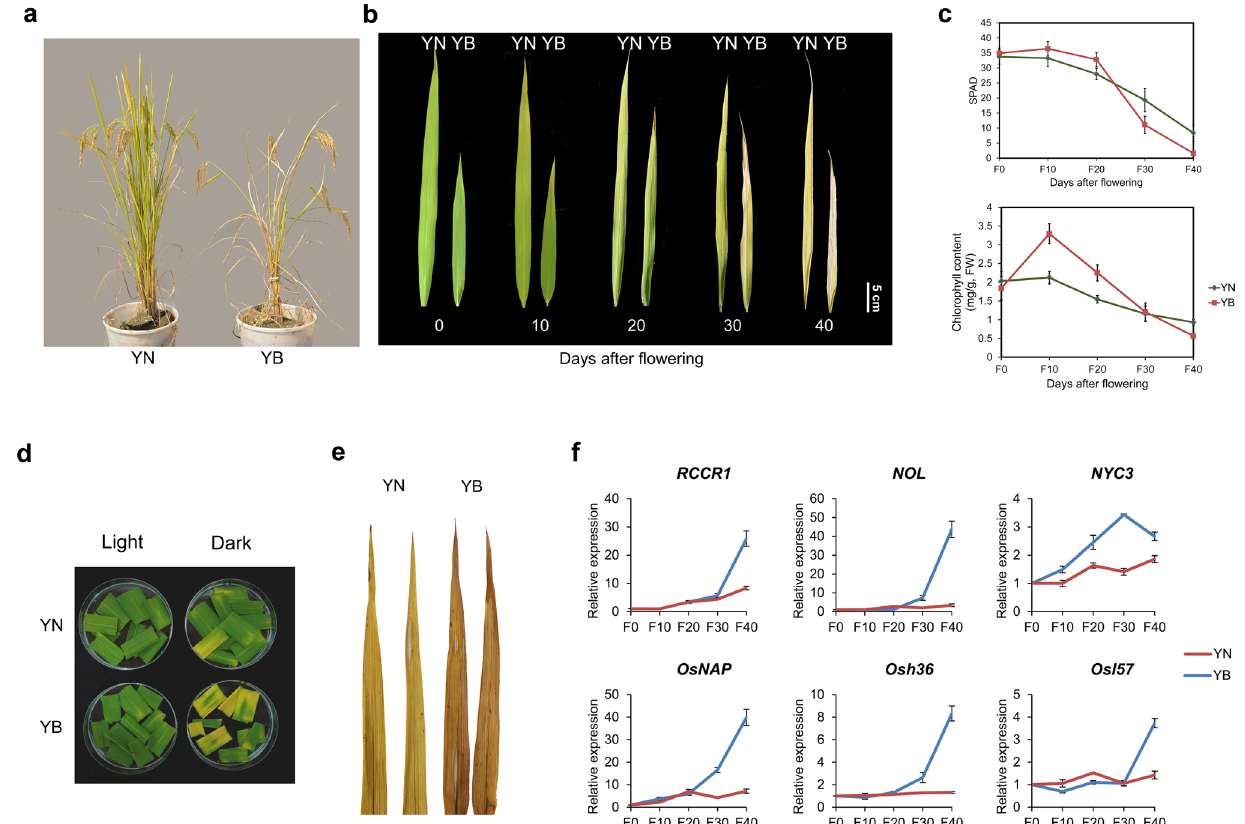
Figure 1. Phenotypes of two rice cultivars. ( a ) Phenotypes of YN and YB at 30 DAF. YN is shown on the left, and YB in shown on the right. ( b ) Phenotypes of flag leaves of YN and YB plants at different stages after flowering. Bars = 5 cm. ( c ) SPAD values and chlorophyll contents of flag leaves of YN and YB plants after flowering. The values are the means ± SDs of 3 measurements. FW fresh weight. ( d ) Detached flag leaves from YN and YB plants at the flowering stage were incubated in water for 5 days in darkness. ( e ) DAB staining of flag leaves of YN and YB at 30 DAF. ( f ) Relative expression of RCCR1 , NOL , NYC3 , OsNAP , Osh36 and OsI57 in YN and YB flag leaves at different stages after flowering. The values are the means ± SDs of 3 tal Table S2). GO and KEGG analyses were performed for the DEGs, revealing information on the annotations of genes involved in biological processes, molecular functions and cellular components (GO analysis) and those